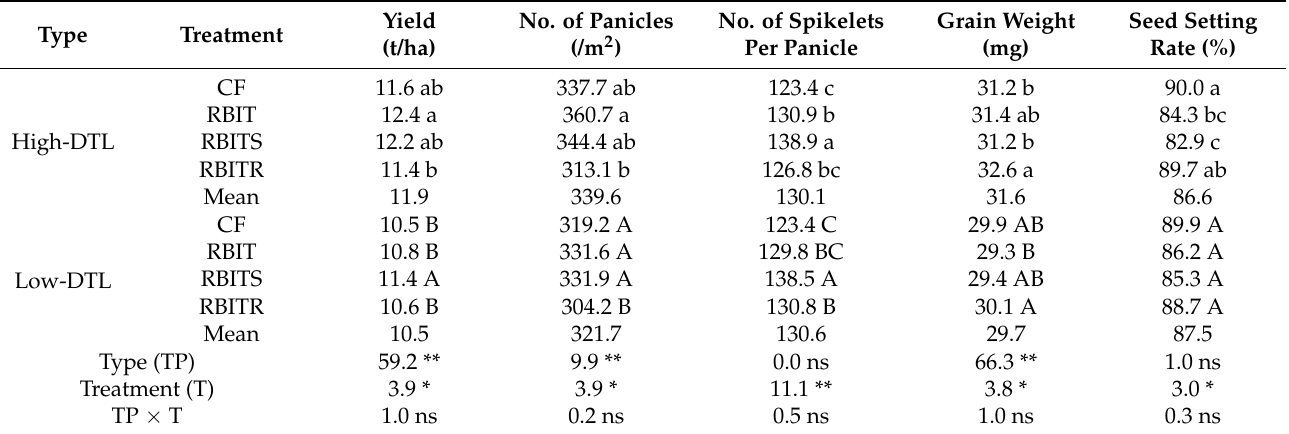
Table 2. Effect of fertilization management under High-DTL and Low-DTL on rice yield and yield